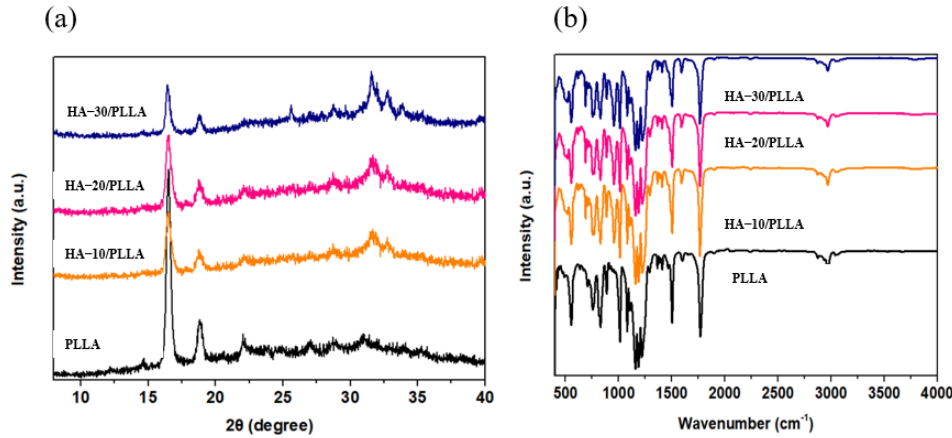
Figure 3. The ( a ) XRD and ( b ) FTIR spectra of PLLA and HA/PLLA composite films.